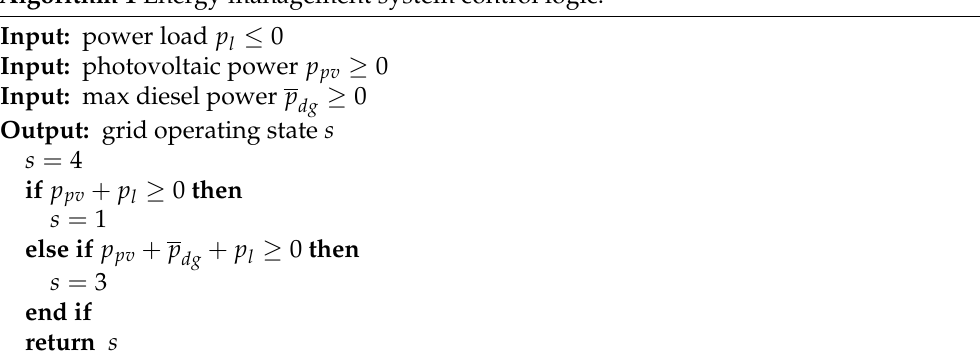
Algorithm 1 Energy management system control